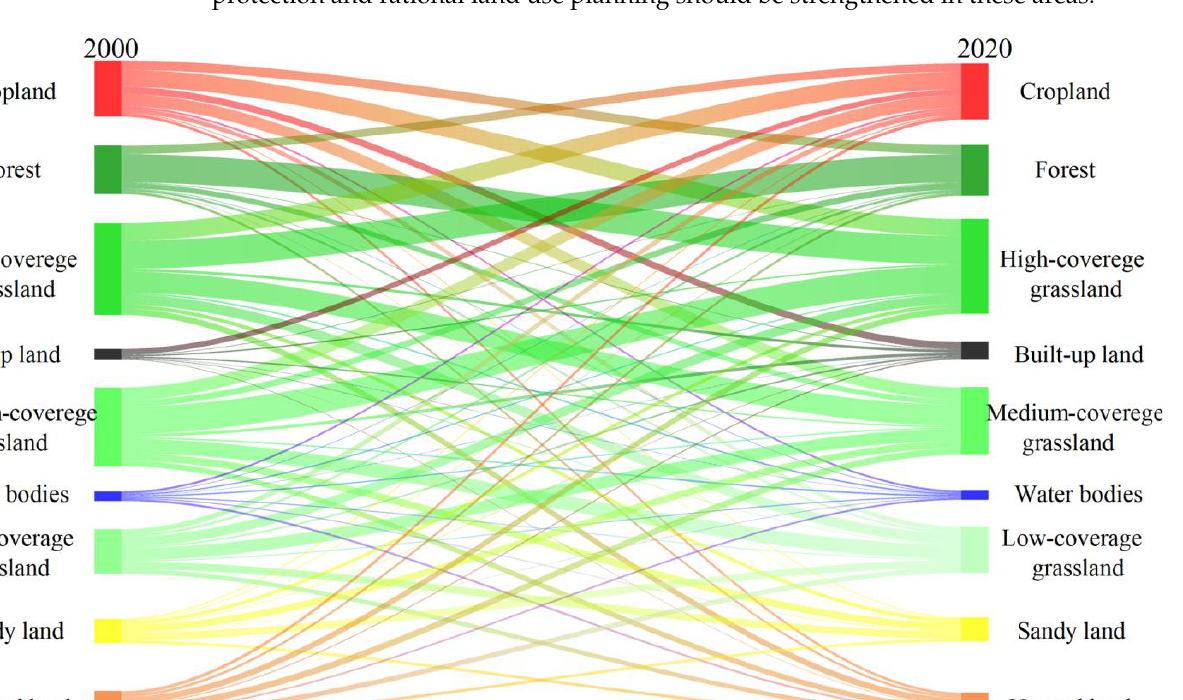
Figure 12. Land use spatial change maps for each league or city in Inner Mongolia from 2000 to 2020.